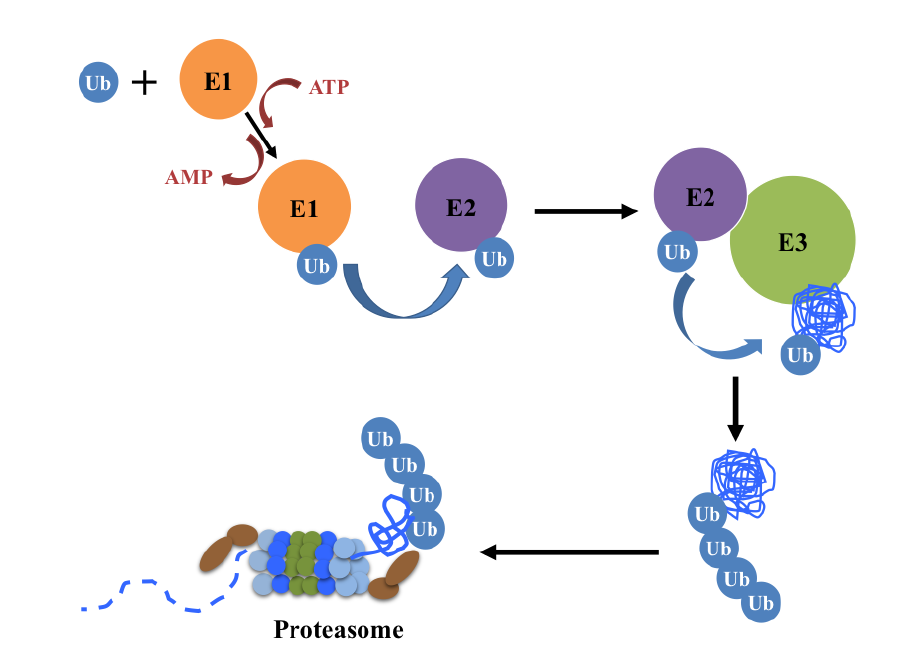
Figure 2. A schematic representation of the ubiquitin-proteasome